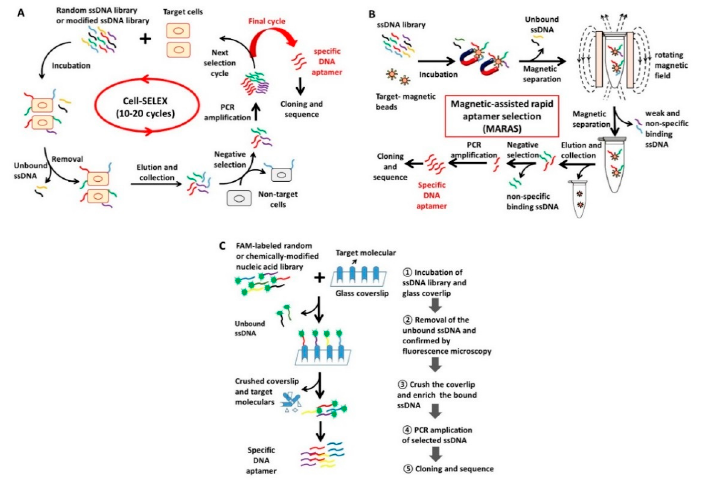
Figure 1. Evolution of methods for DNA aptamers generation. ( A ) Cell-SELEX: The random ssDNA pool is first incubated with target cells on ice. After washing, the bound DNAs are eluted by heating to 95 °C. The eluted DNAs are then incubated with non-target cells for negative selection. Those that do not bind to negative targets are retained and amplified by PCR. The PCR products are separated into ssDNA for further rounds. After 10–20 cycles, the selected ssDNAs are cloned and sequenced for aptamer identification; ( B ) Magnetic-assisted rapid aptamer selection (MARAS): The target-coated magnetic beads are incubated with the ssDNA pool. The beads with bound sequences are then separated from the unbound sequences with a U-shaped magnet or magnetic stand. After re-dispersion, the beads are put in an externally applied rotating or alternating magnetic field. During this process, the weak and non-specific binding sequences are released and separated. The strong-binding sequences are finally released from the beads by heating and then incubated with the beads without a target for the negative selection. The selected sequences are amplified, cloned and sequenced as usual; ( C ) One-step Selection: A FAM-labeled oligonucleotide library is incubated with a target immobilized on a glass coverslip that was coated with N -hydroxysuccinimide (NHS) functionalized polyethylene glycol (PEG). Unbound sequences are discarded by extensive washing followed by monitoring with fluorescence microscopy. The coverslip is later crushed and the bound sequences are eluted by heating in water. The selected aptamers are amplified, cloned and sequenced as usual.